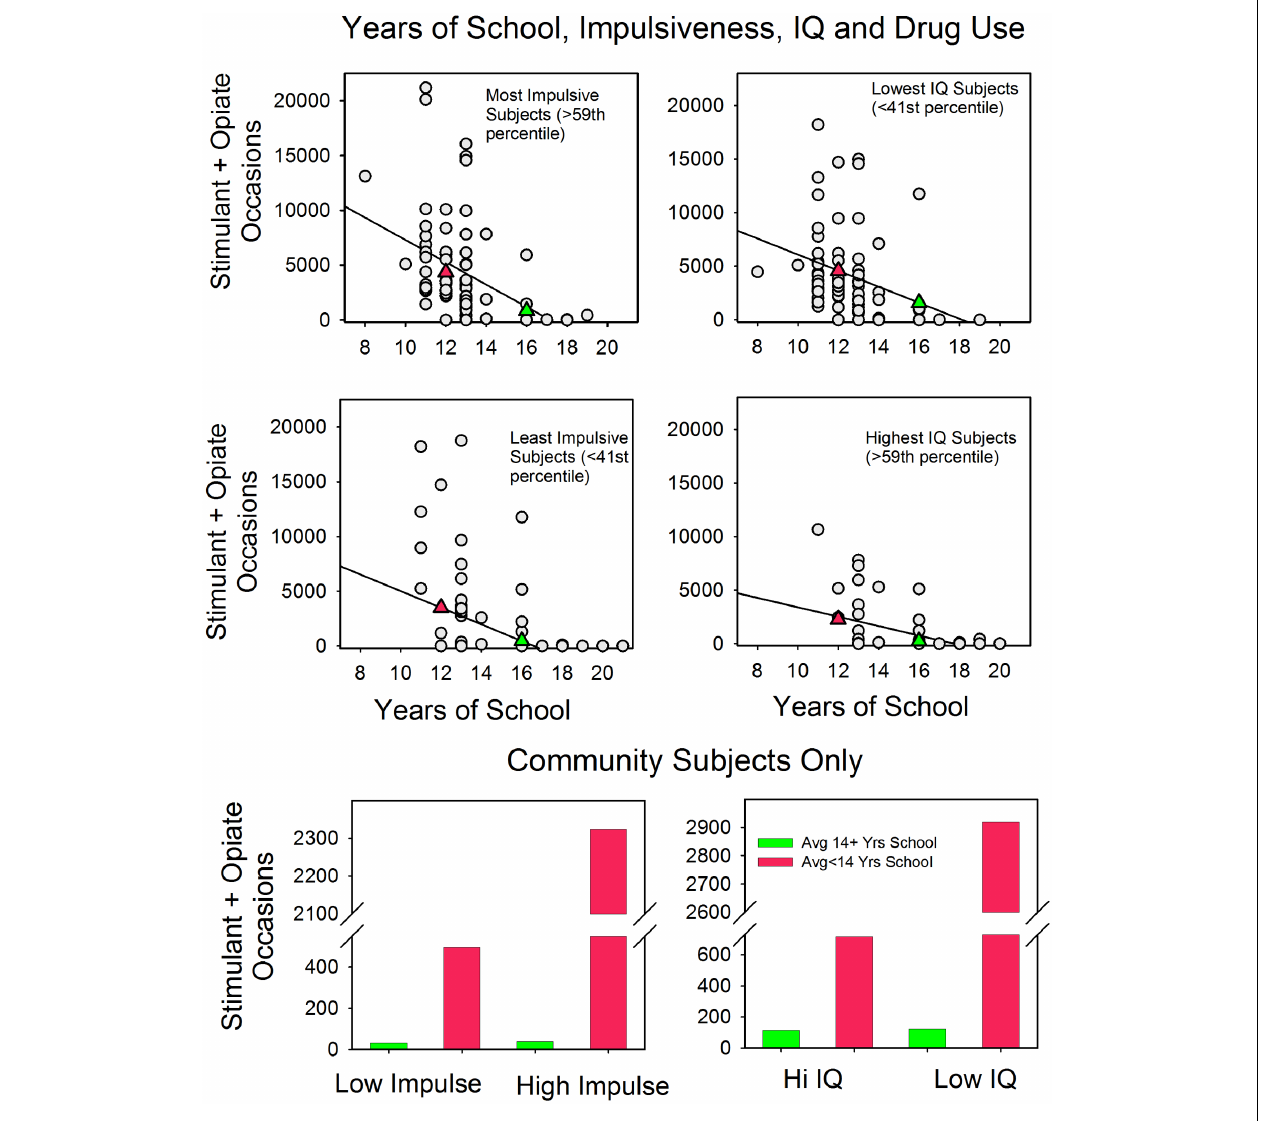
See text for details.The filled triangles indicate the averages for subjects with < 14years-of-school (red) and 14 or more years-of-school (green).The bottom two panels show these relations for just the community subject